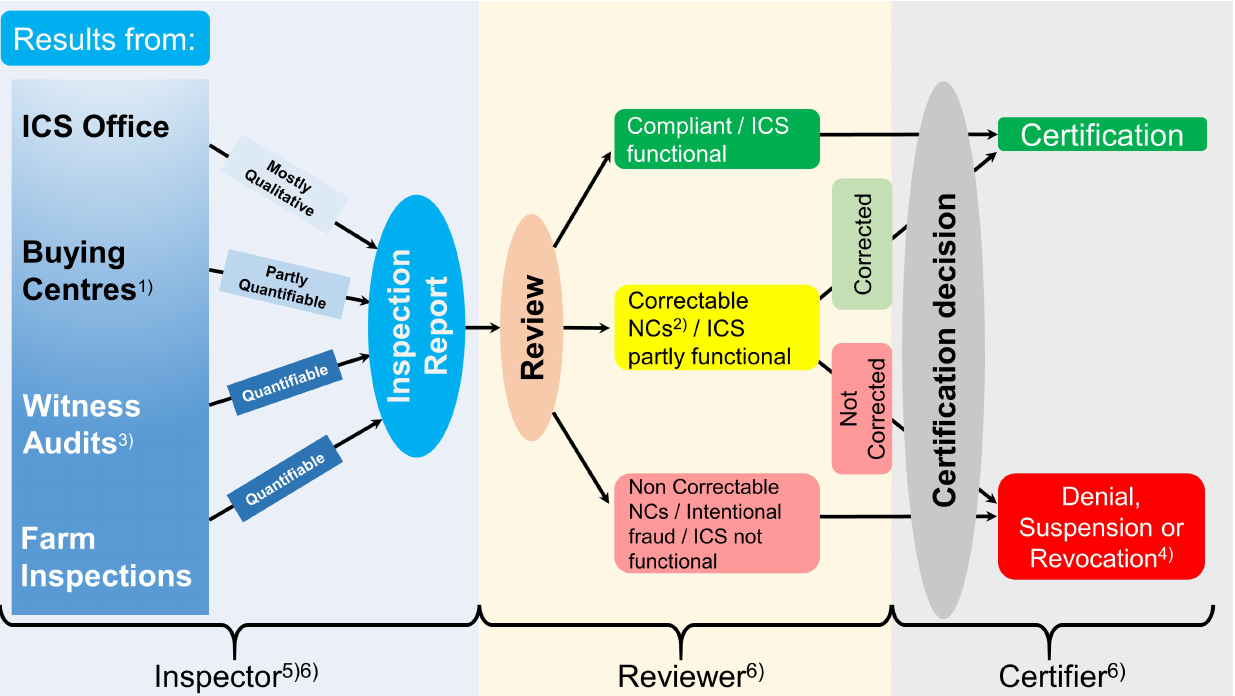
Figure 1. General workflow of an organic group certification process. On the left side, the four on-site inspection activities, for which both the need for, and possibility of, quantification increase from top to bottom. Our article deals mainly with farm inspections and witness audits.